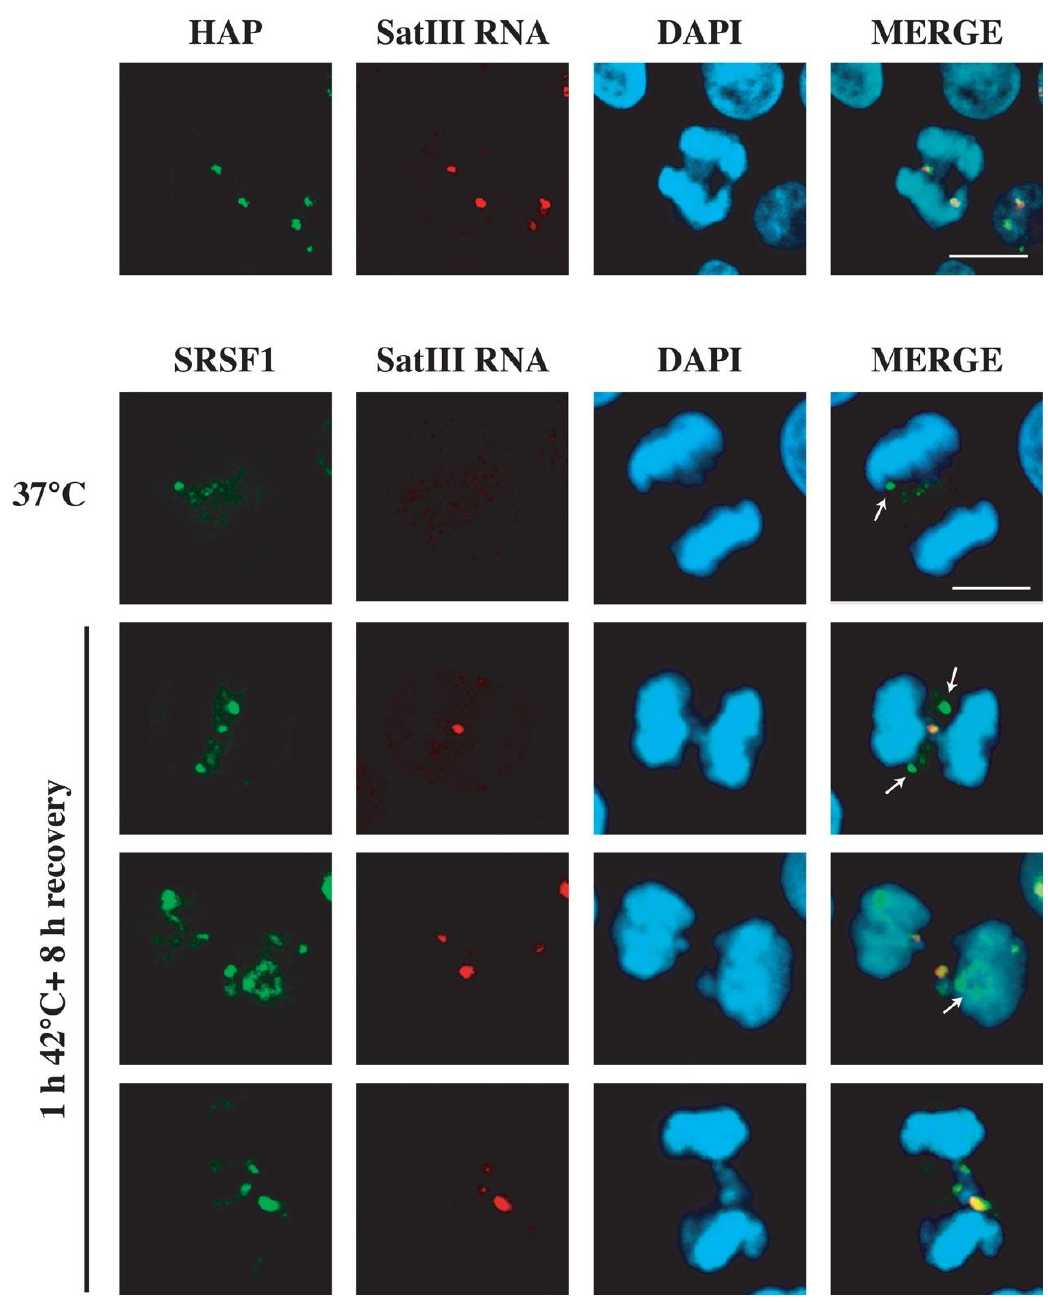
Figure 6. RNA binding proteins remain associated with SatIII RNAs on lagging chromosomes. Heat-shocked HeLa cells were allowed to recover for 6 h at 37 °C and then analyzed using RNA FISH with an oligo specific for SatIII RNAs and co-stained with antibodies specific for hnRNP HAP or splicing factor SRSF1. Nuclei were counterstained with DAPI. The arrows in lane “37 °C” and in the first lane “1 h 42 °C + 8 h recovery” point to mitotic interchromatin granules (MIGs). The arrow in the second lane “1 h 42 °C + 8 h recovery” points to nucleoli organizing region-associated patches (NAPs). Bars: 10 µm